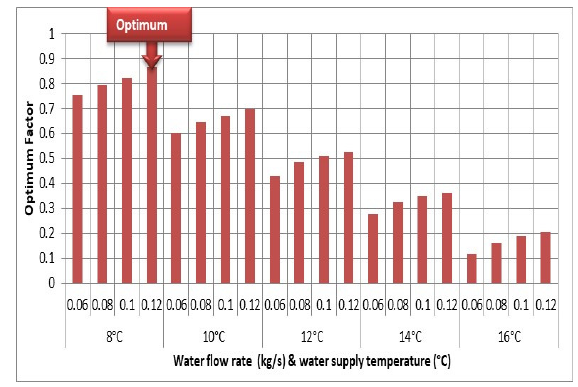
Fig. 16. The flow standard deviation between terminal units at 8 °C water supply temperature and valve opening: Valve 1=100%, Valve 2=100% and Valve 3=100-75-50%.